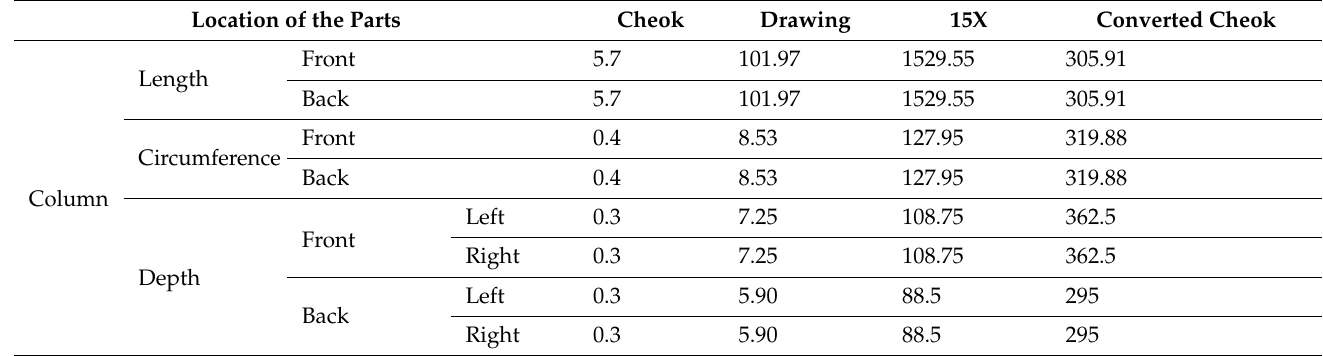
Table 2. Comparison of column dimensions.